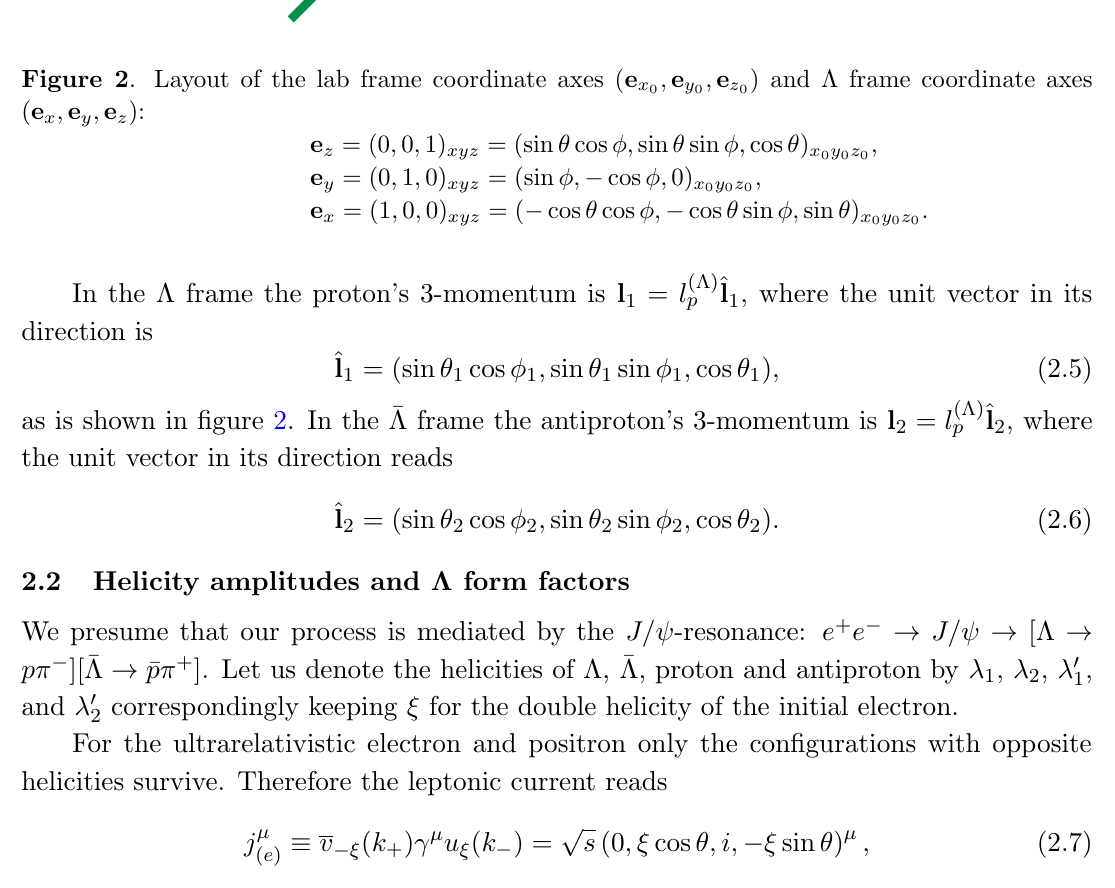
Figure 2 . Layout of the lab frame coordinate axes ( e